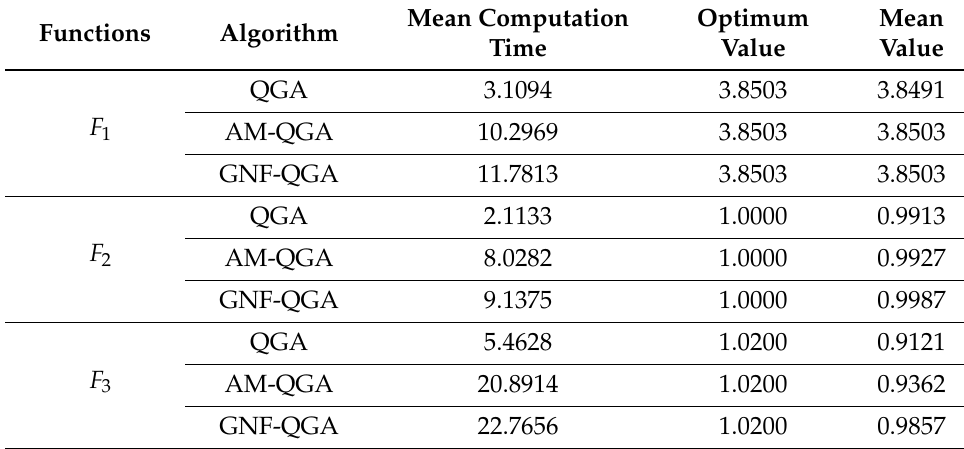
Table 3. Test results and comparison of typical functions.